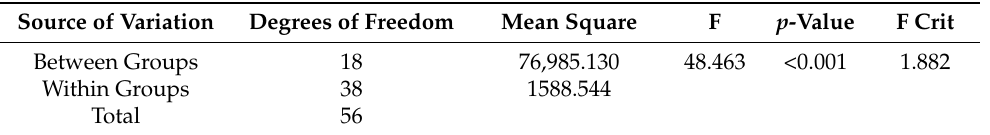
Table 4. Analysis of variance of ergosterol content in a panel of 19 mushroom-based supplements between the mean values determined on 3 different